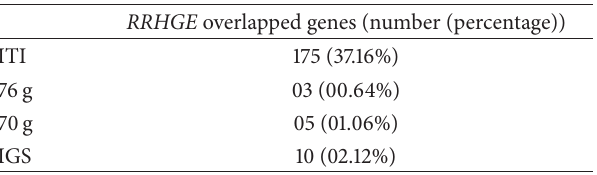
Table 5: Number of overlapped genes of the RRHGE gene signature with ITI, 76 g, 70 g, and